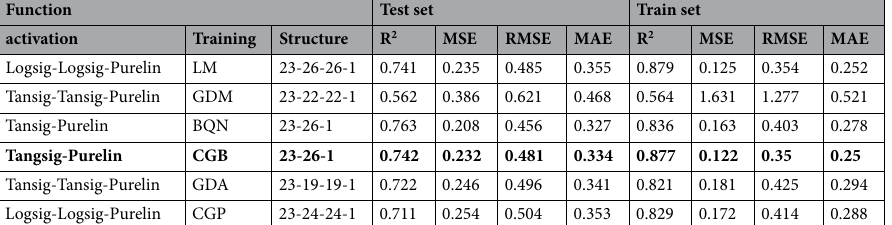
Table 3. The performance of the best artificial neural networks for the forecast of NO 2 concentration in the air. LM Levenberg–Marquardt, GDM gradient descent with momentum, BQN BFGS quasi newton, CGB conjugate gradient with Powell/Beale, GDA gradient descent with adaptive learning rate, CGP conjugate gradient with